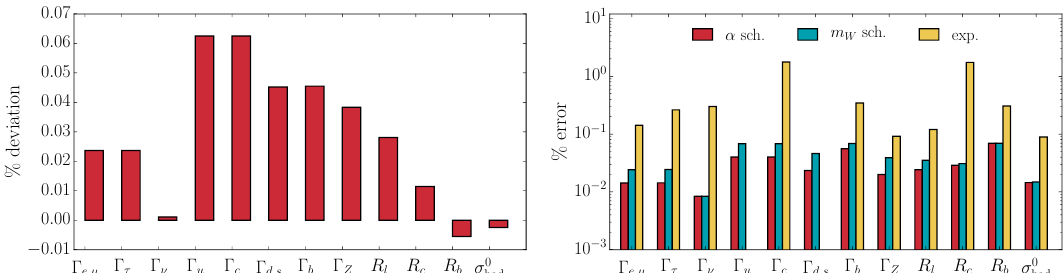
X (cid:11) ) =X (cid:11) 100%. The right W (cid:0) (cid:2) ^ (cid:11); ^ m Z ; ^ G F scheme (left f g ^ m W ; ^ m Z ; ^ G F scheme (middle f g